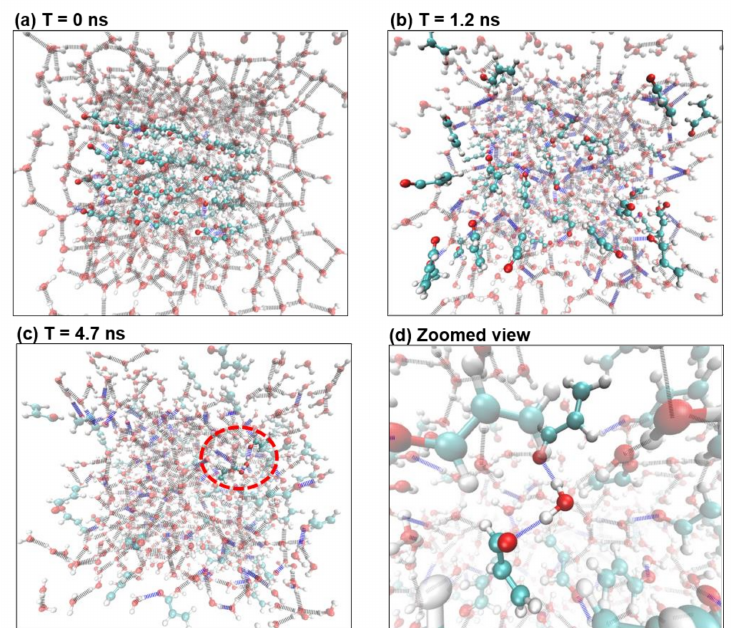
Figure 8. Acrolein molecules solvated in water. ( a ) T = 0 ns; ( b ) T = 1.2 ns, where more hydrogen bonds formed between water and acrolein; ( c ) T = 4.7 ns; ( d ) The circled portion from ( c ), showing two acrolein molecules connected by a water molecule through hydrogen bonds (the rest of the molecules are set to be transparent). Color scheme: Hydrogen in white, oxygen in red, carbon in cyan, blue for hydrogen bonds between waters and acrolein, and grey for hydrogen bonds between water